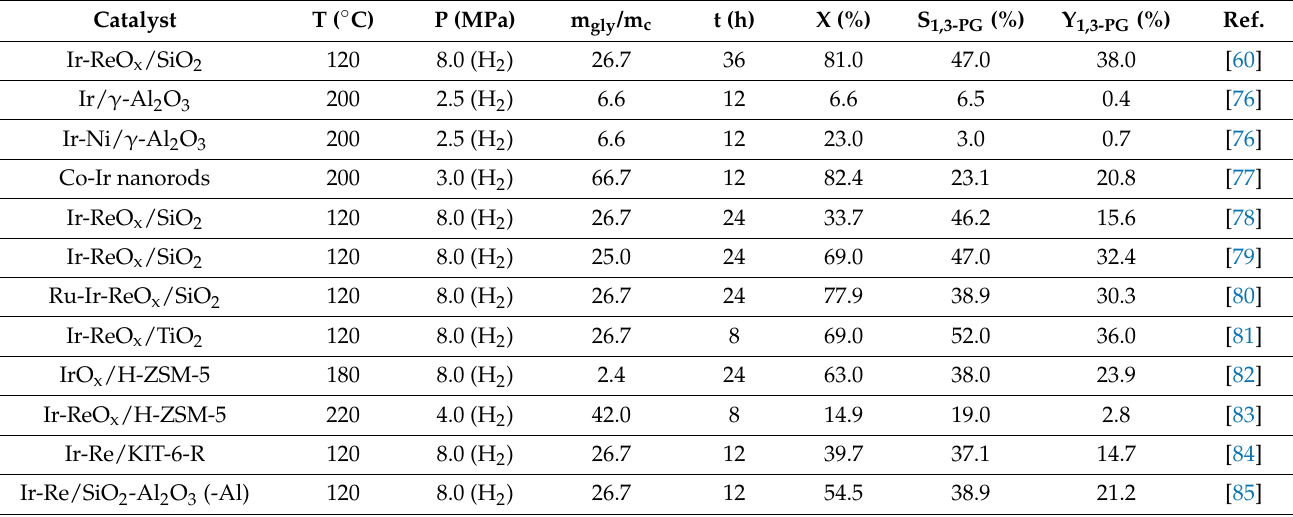
Table 3. The hydrogenolysis of glycerol to 1,3-PG using Ir catalysts operating in liquid phase batch